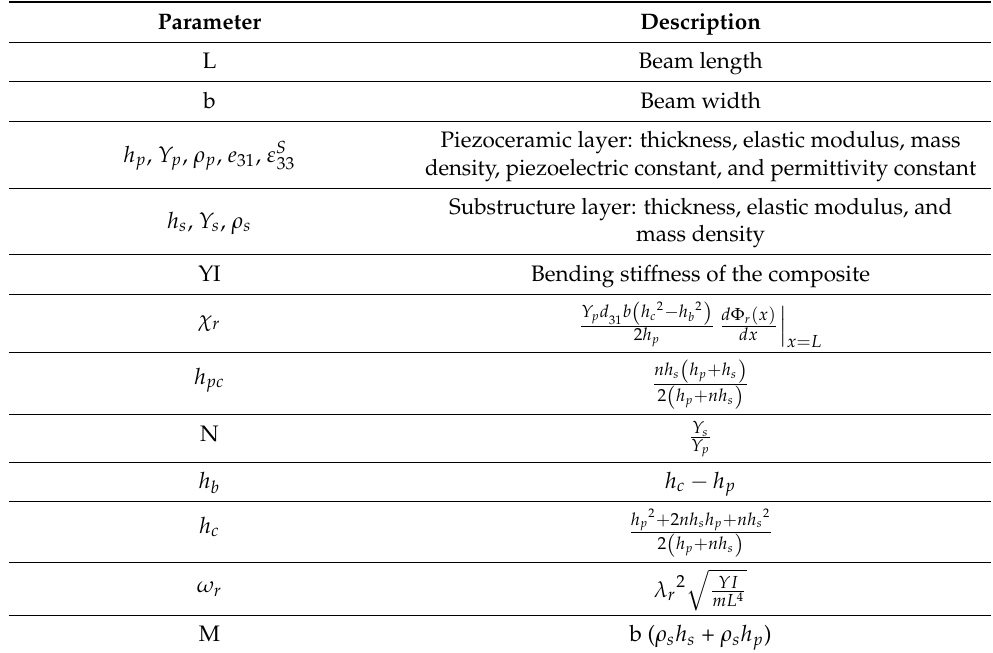
Table 1. Parameters of the model.